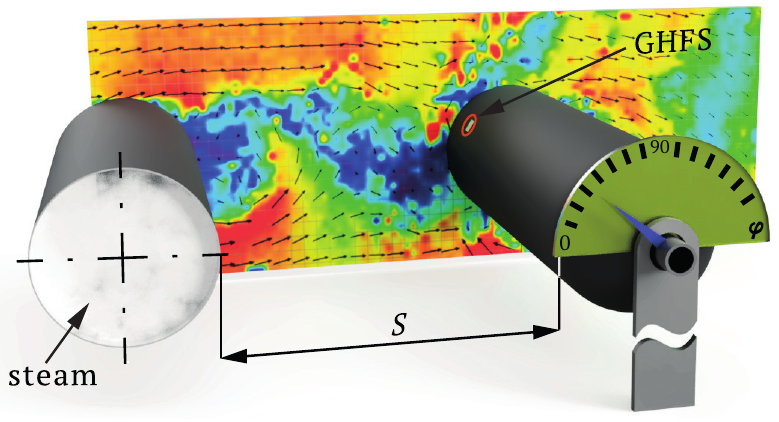
Figure 2. Flow around a cylinder